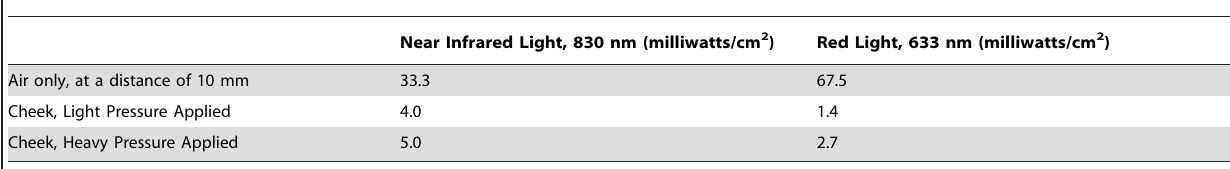
Table 6. Transmission of Near Infrared and Red Light through a Human Cheek.